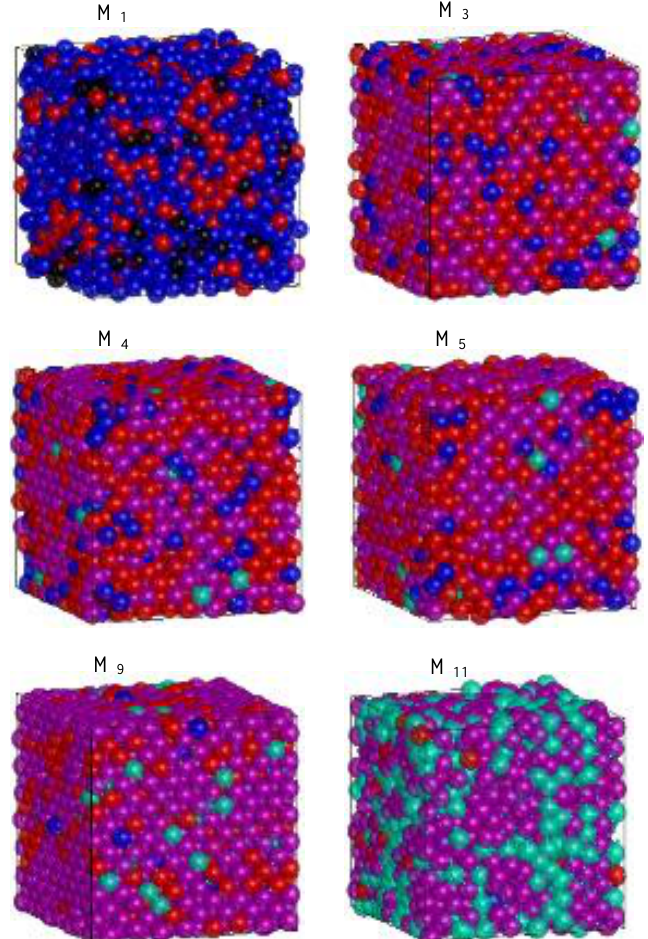
Figure 9. Snapshots of spatial distribution of AlO 3 units (in black spheres), AlO 4 (in blue spheres), AlO 5 (in red spheres), AlO 6 (in pink spheres) and AlO 7 (in turquoise spheres) for liquid Al 2 O 3 at pressures of 0, 10, 15, 20, 60 and 100 GPa (M 1 , M 3 , M 4 , M 5 , M 9 , M 11 ) and 3500